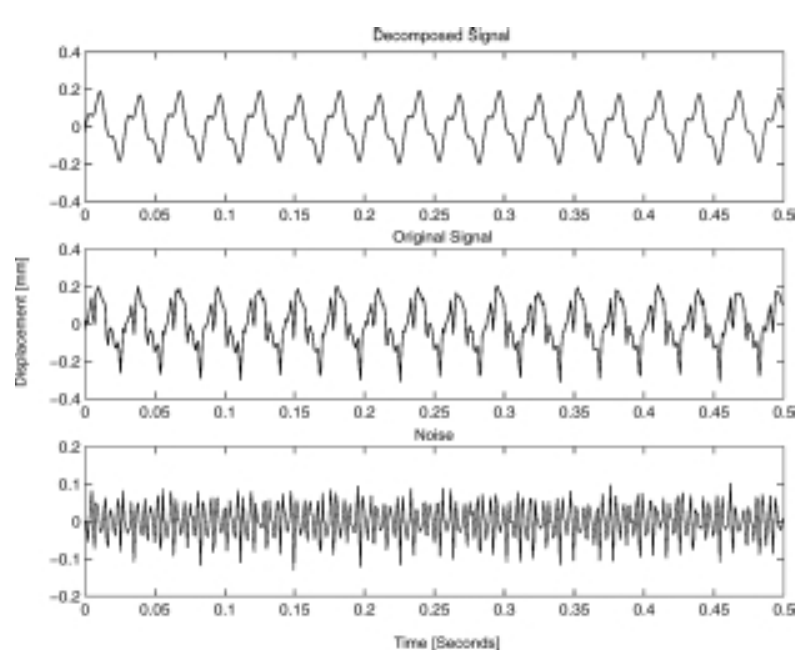
Fig. 3. Sample of a measured signal and its decomposition by